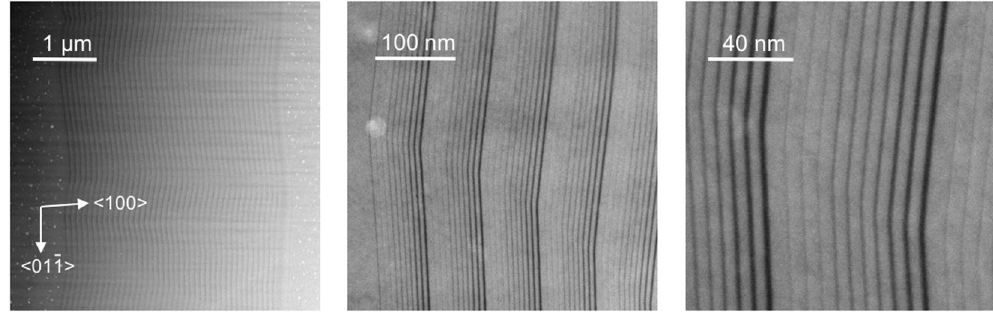
Figure 1. High angle annular dark field STEM images of the QCL active zone grown on Si at different magnifications. Dark regions correspond to AlSb layers. The substrate is on the